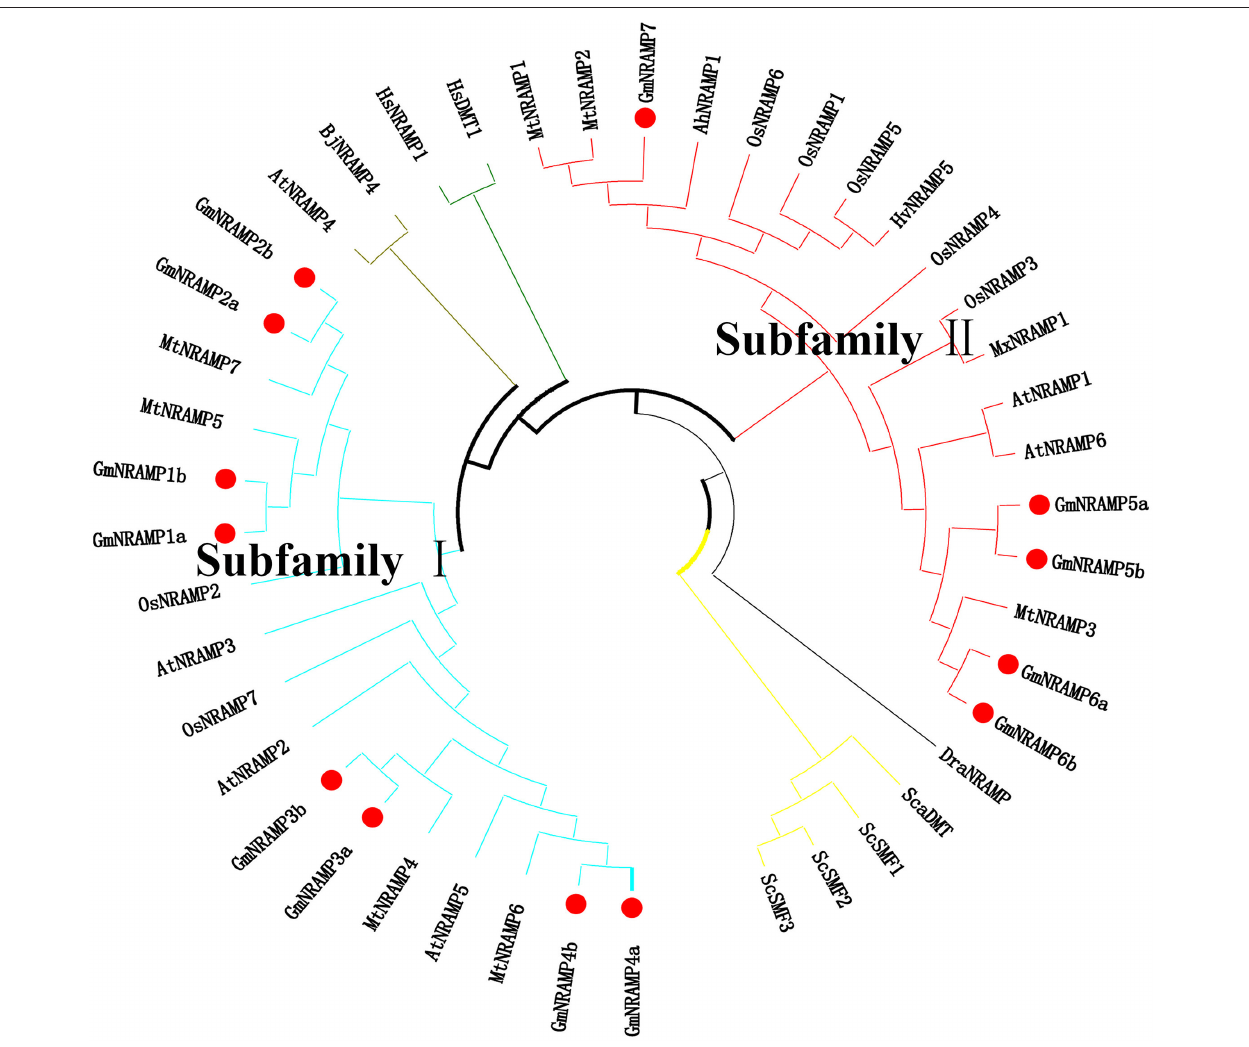
FIGURE 3 | Phylogenetic relationship of NRAMP family genes from soybean and other species. The phylogenetic tree was constructed based on sequence alignment of NRAMP homologs from Soybean (Gm), Arabidopsis (At), Rice (Os), Medicago (Mt), Barley (Hv), Peanut (Ah), Apple (Mx), Mustard (Bj), Yeast (Sc and Sca), Deinococcus radiodurans (Dra), and Human (Hs) using the neighbor-joining method with bootstrapping analysis in MEGA 6.0 (1,000 replicates). The 44 included NRAMP proteins from 11 species are divided into different branches with different color labels. Plant NRAMP proteins, with one exception cluster into two groups (subfamily I and subfamily II). Soybean NRAMP proteins are shown in bold with red filled